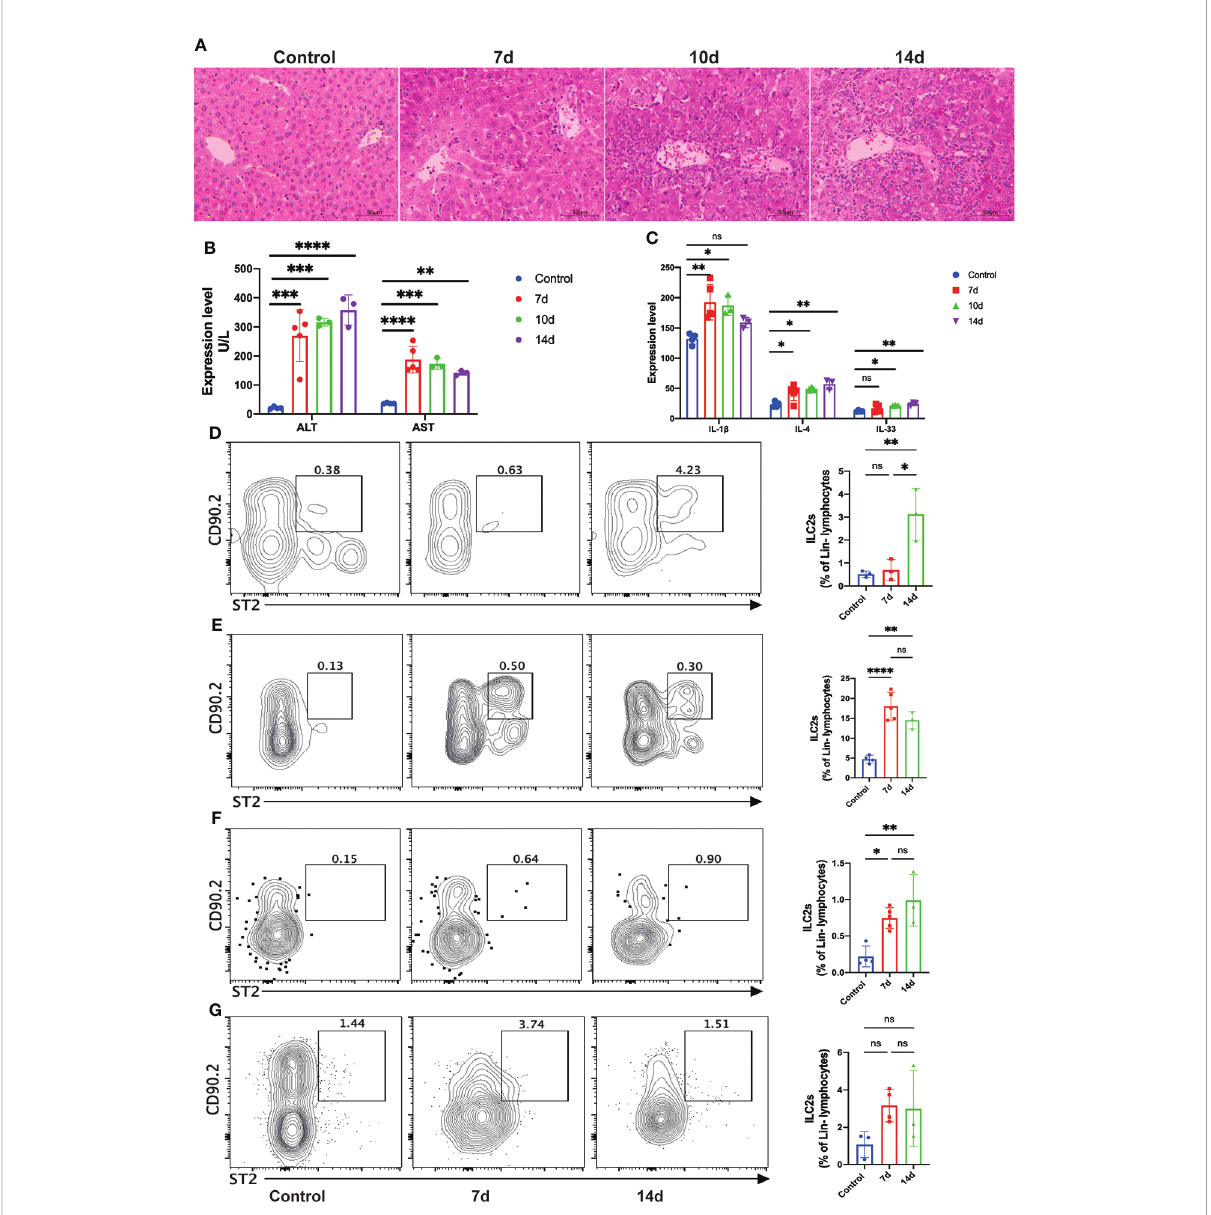
FIGURE 3 Allograft in fi ltrating group 2 Innate lymphoid cells (ILC2s) were signi fi cantly increased after liver transplantation (LT) in the mouse LT model. (A) Representative hematoxylin and eosin (H&E) staining of fi xed and paraf fi n-embedded mouse liver tissues after LT. Scale bar, 50 m m. (B) The plasma levels of ALT and AST were signi fi cantly increased after LT (control group, n = 4; 7d group, n = 5; 10d group, n = 3; 14d group, n = 3). (C) The plasma levels of IL-1 b , IL-4, and IL-33 were increased after LT (control group, n = 4; 7d group, n = 5; 10d group, n = 3; 14d group, n = 3). (D) Hepatic ILC2s dramatically expanded at 14 days after LT (control group, n = 3; 7d group, n = 3; 14d group, n = 3). (E) The frequency of ILC2s in bone marrow was signi fi cantly increased at seven days post-transplant and slightly decreased after 14 days (control group, n = 4; 7d group, n = 5; 14d group, n = 3). (F) There was a signi fi cant increase in the frequency of splenic ILC2s within two weeks post-transplant (control group, n = 4; 7d group, n = 5; 14d group, n = 3). (G) No considerable increase of ILC2s was observed in mesenteric lymph nodes (control group, n = 3; 7d group, n = 4; 14d group, n = 3). * p < 0.05; ** p < 0.01; *** p < 0.001. **** p < 0.0001, ns p >